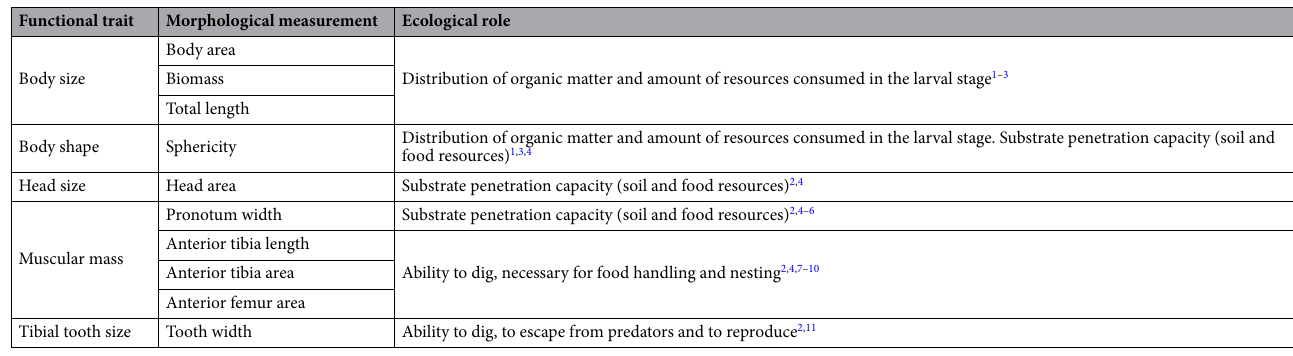
Table 1. Functional traits of dung beetles and their ecological role. The references of this table are in Appendix S2 in Supporting information.